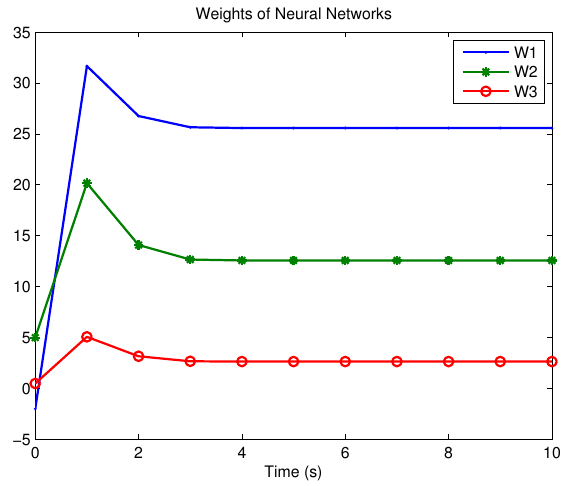
Figure 13. Neural network weight.